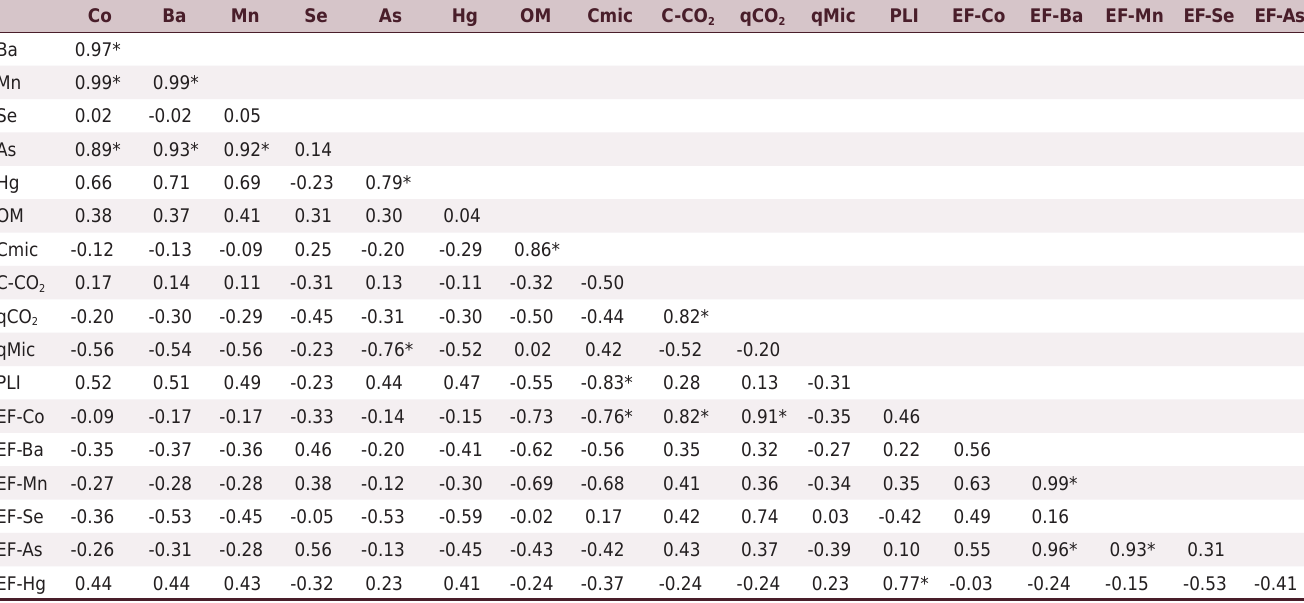
Table 7. Pearson correlation matrix between the available contents of potentially toxic elements, soil biological properties, enrichment factor (EF), and pollutant load index